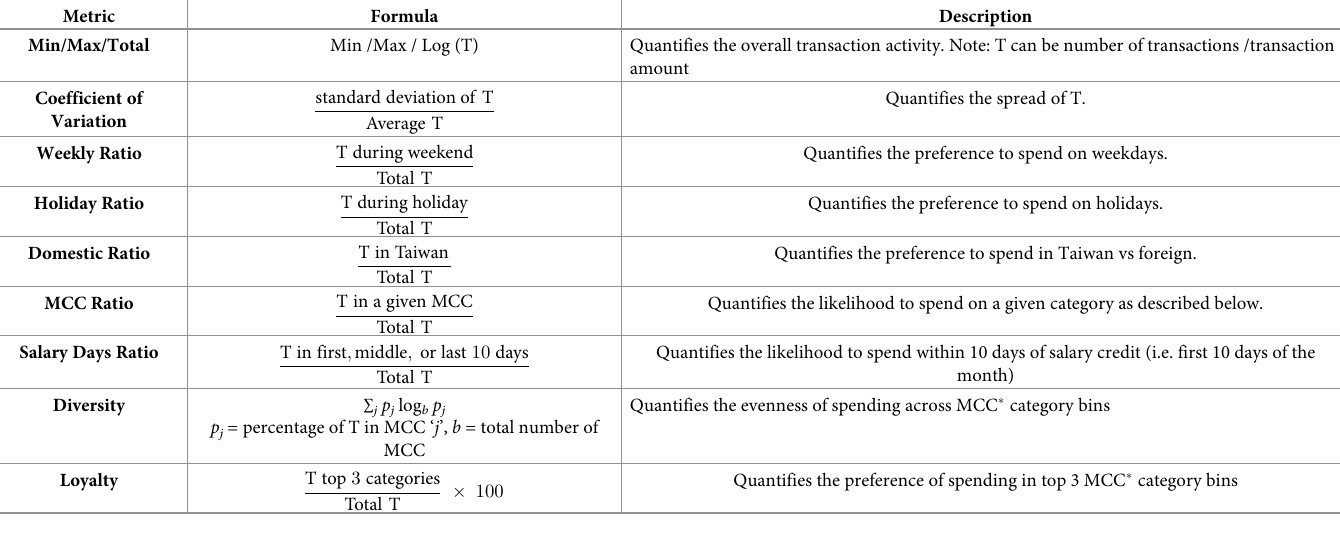
Table 4. Transaction based